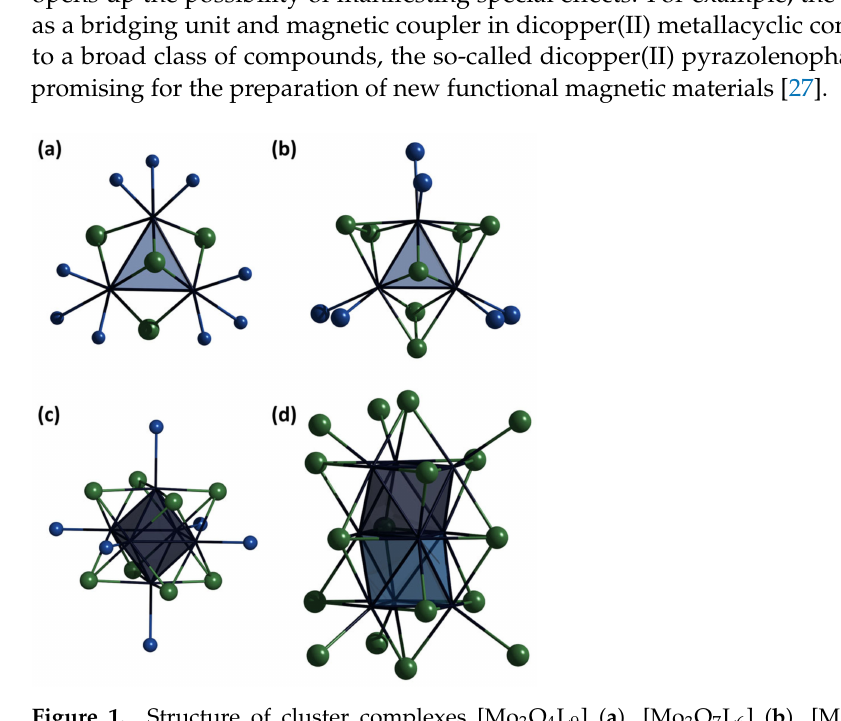
Figure 1. Structure of cluster complexes [Mo 3 Q 4 L 9 ] ( a ), [Mo 3 Q 7 L 6 ] ( b ), [Mo 6 Q 8 L 6 ] ( c ), and [Mo 9 Se 11 ] ( d ). Color code: Mo—dark blue, Mo 3 /Mo 6 —blue triangle/octahedron, Q—green,